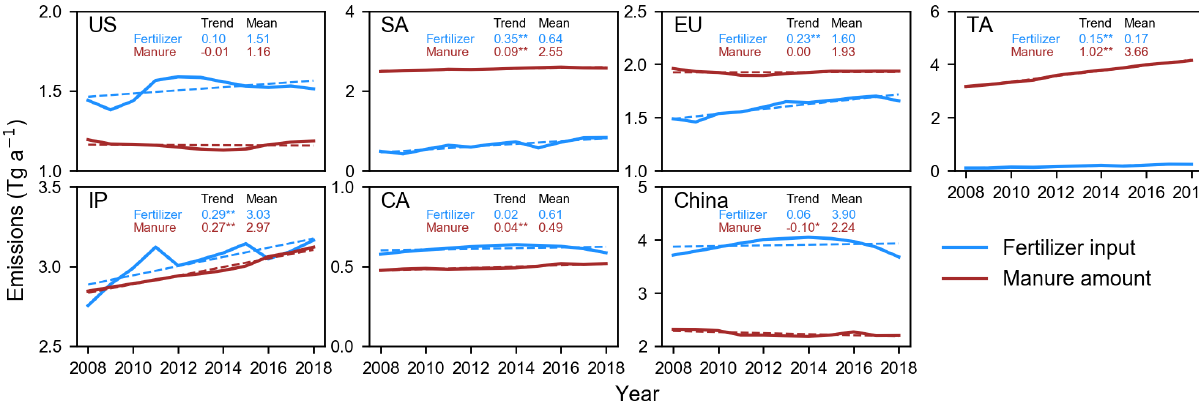
Figure 4. Synthetic fertilizer and livestock manure amount based on FAO reports (http://www.fao.org/faostat, last access: 7 May 2022) during 2008–2018. To roughly compare the contribution from the two sectors, we convert FAO-reported statistics to NH 3 emissions (Tga − 1 ) by applying fixed emission factors of 13% for manure N contents (Ma et al., 2021) and 17% for synthetic fertilizer N contents (Riddick et al., 2016). The values of means (Tga − 1 ) and linear trends (Tga − 1 per decade) are inset. Scales differ between panels.